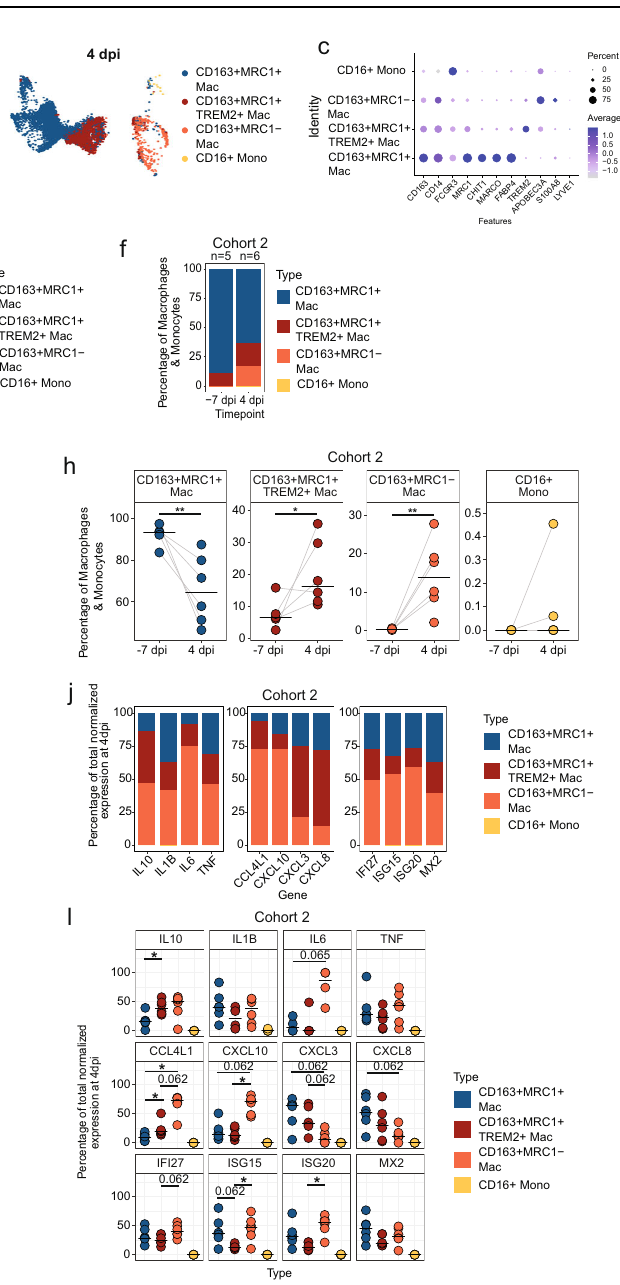
Fig. 3 | In fl ux of pro-in fl ammatory macrophages in BAL. a Projection of single- cell macrophages/monocytes from − 5dpi (green) and 4dpi (magenta) 10X BAL samples obtained from three SARS-CoV-2 infected rhesus macaques (Cohort 1) ontothereferenceUMAPoflungmacrophage/monocytesfromuninfectedrhesus macaques (NCBI GEO: GSE149758 33 ). b UMAP projections showing the predicted cell type annotations based on the uninfected lung reference split by time of sample collection (Cohort 1). c DotPlots showing the expression of marker genes for the different macrophage/monocyte subsets in SARS-CoV-2 infected BAL samples(Cohort1). d Log2fold-changescomparedto − 5dpiforAPOBEC3A,CHIT1 and MARCO in bulk BAL RNA-Seq data (Cohort 1). Signi fi cance was determined using DESeq2. The p values corrected by the default Benjamini and Hochberg methodwereused*adj p value<0.05,***adj p value<0.001.The exact p valuesare included in Supplementary Data 2. Percentage of a given subset out of all mac- rophage/monocyte subsets at − 5dpi and 4dpi from all three animals pooled (Cohort 1) ( e ) and at − 7dpi and 4 dpi from all six animals pooled (Cohort 2) ( f ). Percentage of a given subset out of all macrophage/monocyte subsets for each